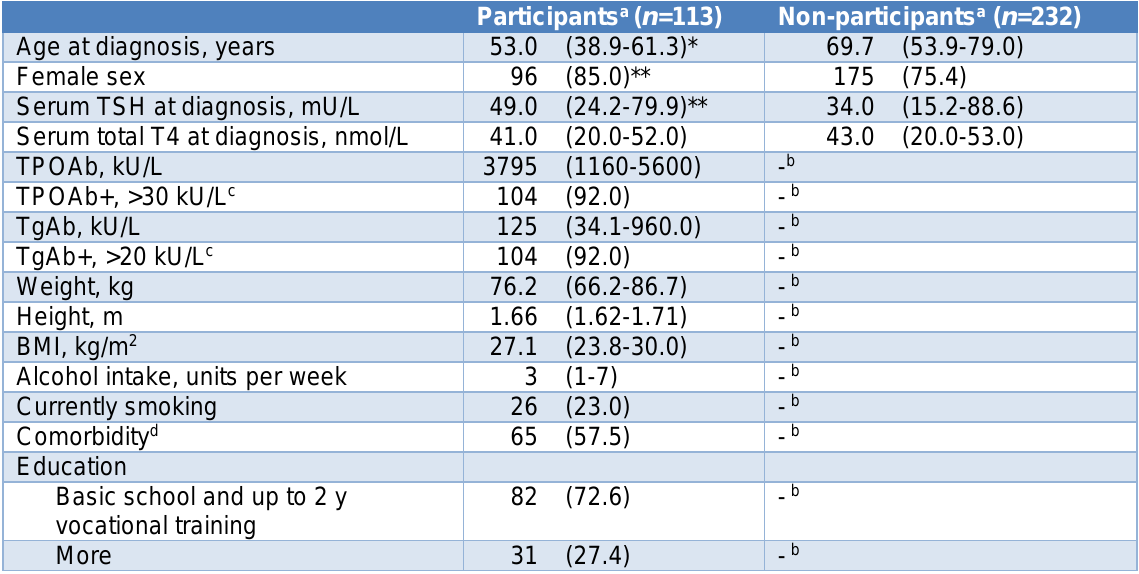
Table 1: Baseline characteristics of participants in the investigational program and the non-participants